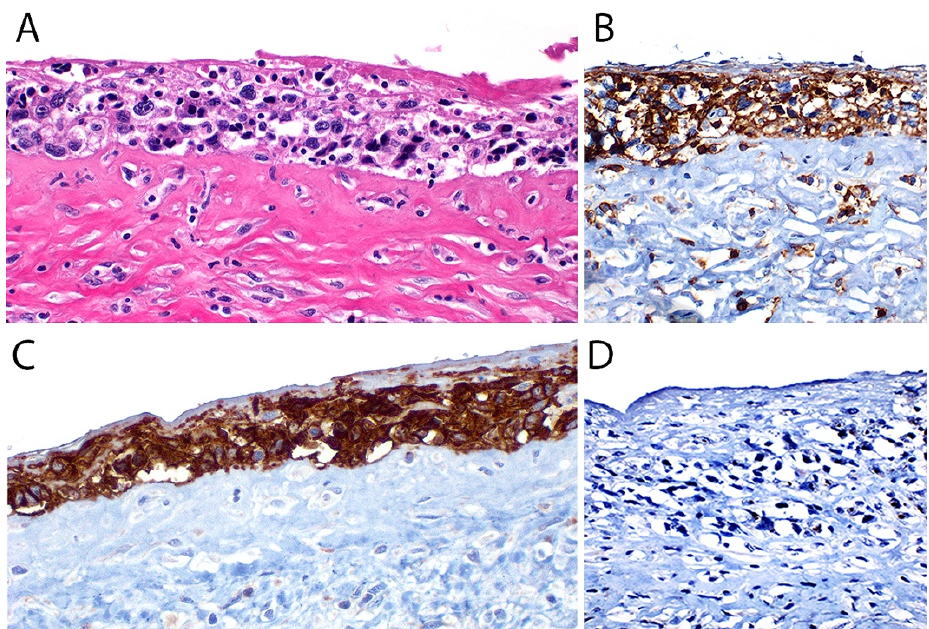
Figure 17. ( A ) Histologic section of the breast fibrous capsule shows numerous atypical large lym- phoid cells with pleomorphic nuclei admixed with fibrino-necrotic debris on the luminal side. These cells are positive for ( B ) CD45 and ( C ) CD30, and negative for ( D ) ALK. CD30 is also positive in